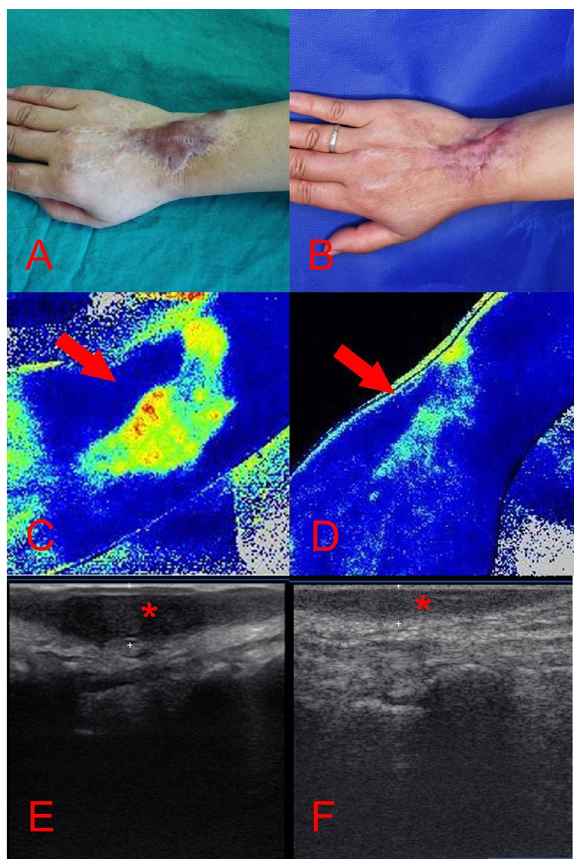
Figure 4. A 49-years-old woman [case 19] sustained a post-traumatic hypertrophic scar over 2-years prior to treatment ( A ); after 6 months follow-up and 2 laser sessions ( B ); the scar blood perfusion was significantly decreased: prior the operation was 104.29 Units ( C ), post operation there was a reduction of 28.46% ( D ); the scars thickness prior to the operation was 0.73 cm ( E ), post operation was decreased 43.84% ( F